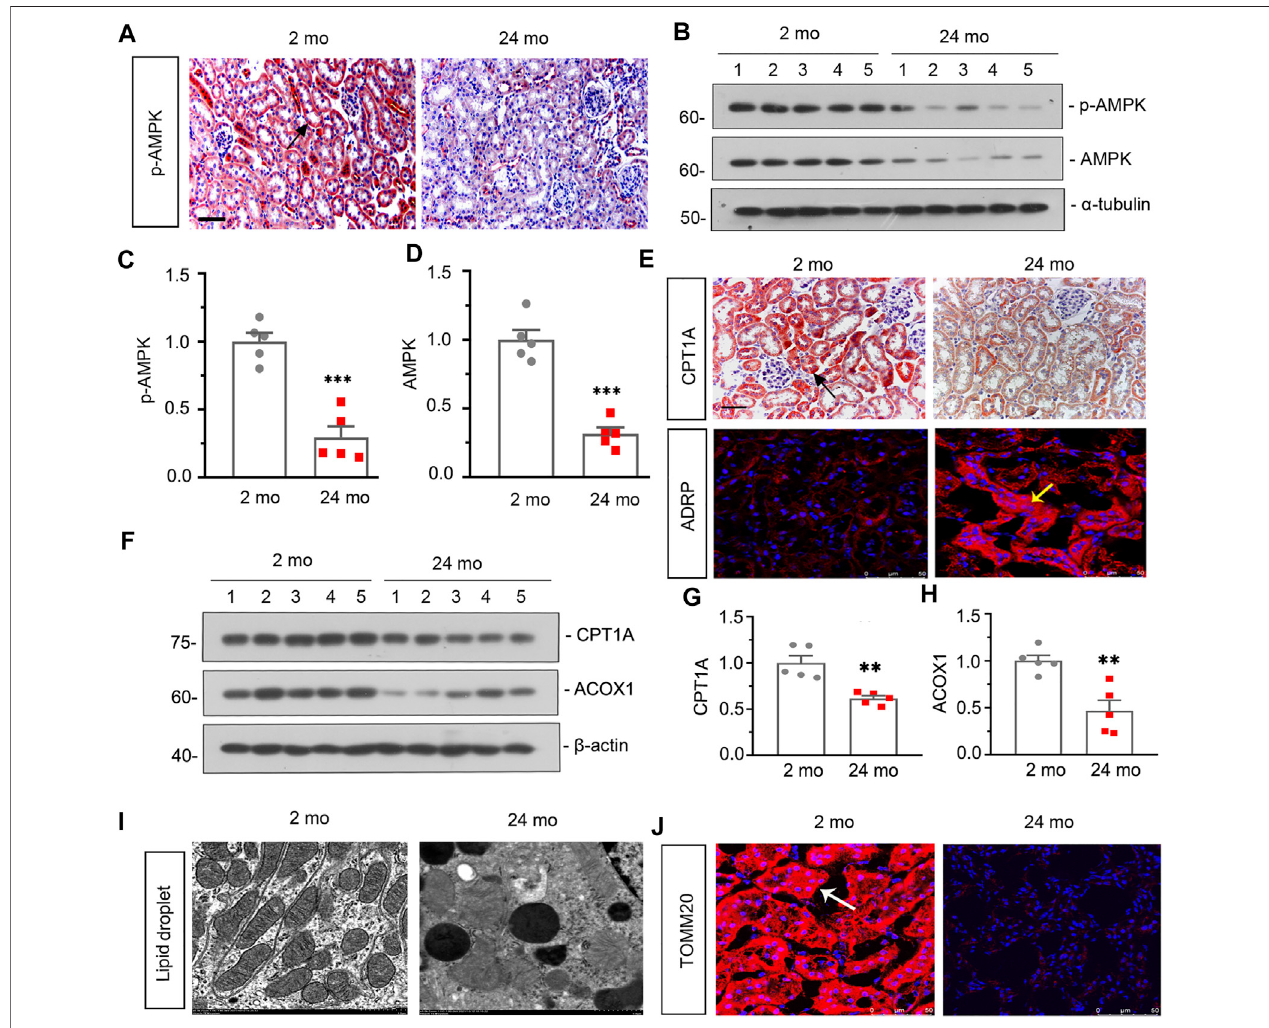
FIGURE 1 | Aged kidney is associated downregulation of AMPK and dysfunction of fatty acid metabolism and mitochondria (A) Representative micrographs showing p-AMPK expression in kidneys in 2-month-old and 24-month-old mice. Paraf fi n-embedded kidney sections were immunostained with an antibody against p-AMPK. Arrows indicate positive staining. scale bar, 50 μ m. (B – D) Representative western blot and quantitative data showing renal expression of p-AMPK and AMPK in 2-month-old and 24-month-old mice. Numbers (1 – 5) indicate each individual animal in each given group. *** p < 0.001 versus 2-month-old mice group. (E) Representative micrographs showing CPT1A (top) and ADRP (bottom) expression in kidneys in two groups. Paraf fi n-embedded kidney sections were immunostained with an antibody against CPT1A. Cryosections were subjected to fl uorescence staining for ADRP. Arrows indicate positive staining. scale bar, 50 μ m. (F – H) RepresentativewesternblotandquantitativedatashowingrenalexpressionofCPT1AandACOX1in2-month-oldand24-month-oldmice.Numbers(1 – 5)indicateeach individual animal in each given group. ** p < 0.01 versus 2-month-old mice group. (I) Representative transmission electron microscopy (TEM) micrographs show fat dropletinultrathinkidneysections. (J) RepresentativemicrographsshowingTOMM20expressioninkidneysin2-month-oldand24-month-oldmice.Cryosectionswere subjected to fl uorescence staining for TOMM20. Arrows indicate positive staining.